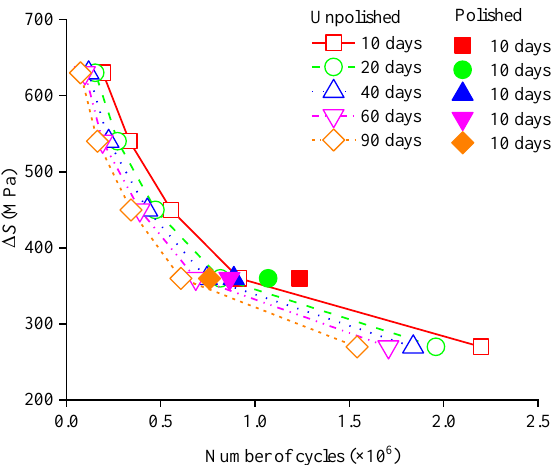
Figure 15. Relationship between fatigue life and quality loss of pre-corroded steel wire.